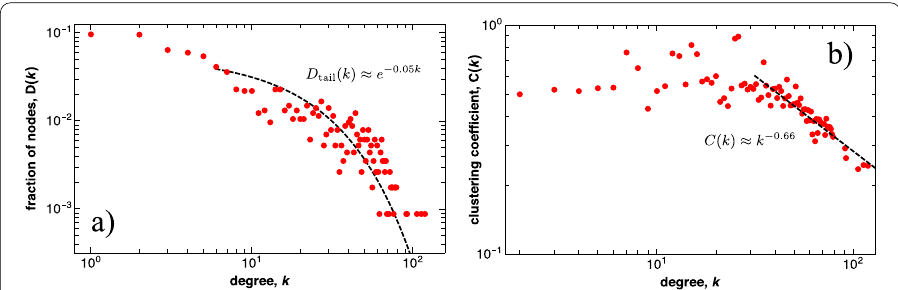
Fig. 2 Panel a shows the degree distribution, D ( k ). The dashed black line represents the best exponential distribution fitted to the empirical distribution’s tail ( k > 5 ). Panel b shows the average clustering coefficient average per degree, C ( k ). The dashed black line shows the best linear fit. The results have been estimated from the entire graph